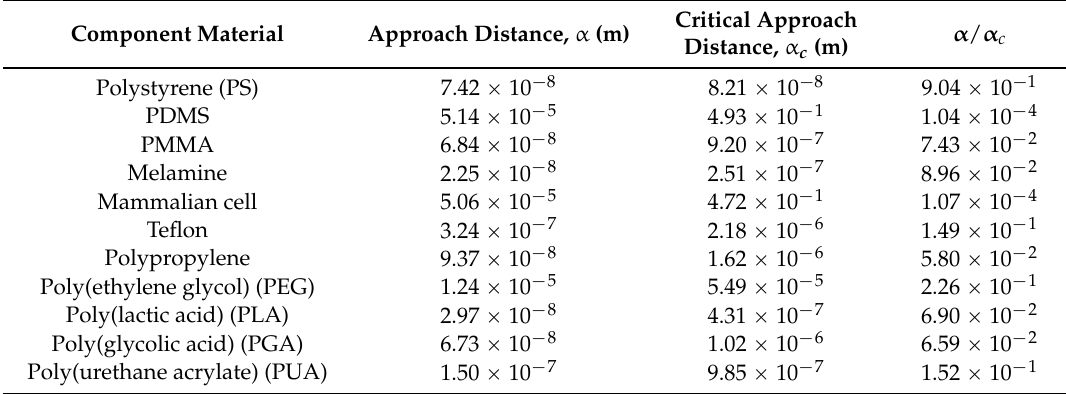
Table 3. Approach distance calculated inside a hemicylindrical assembly site and comparison with critical approach values. Calculations assume a mean well diameter of 27 µ m, a cylindrical microcomponent with diameter of 26 µ m and contact length of 50 µ m, and an applied contact load of 3.3 ˆ 10 ´ 3